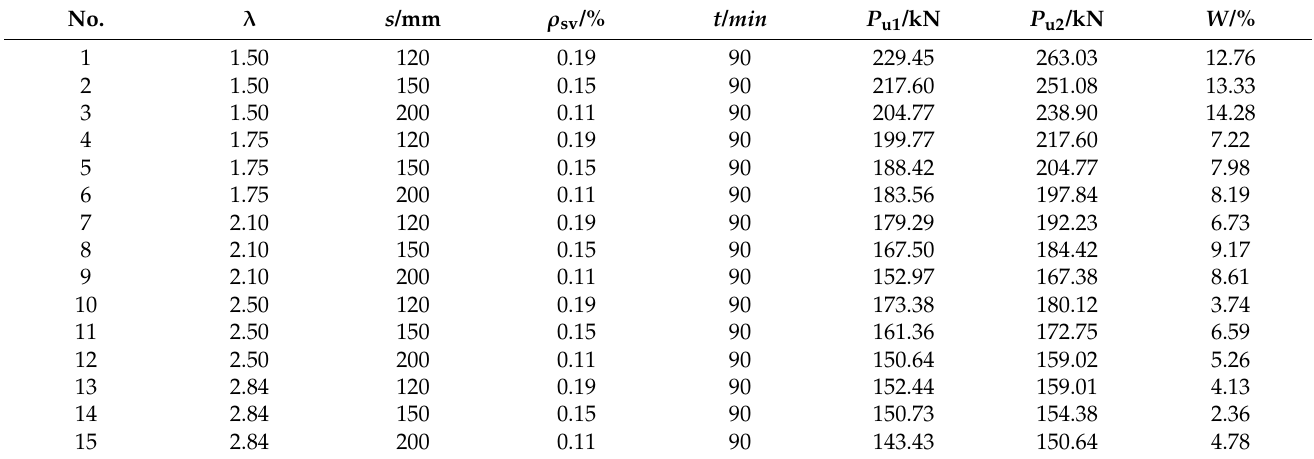
Table 3. Comparison of the failure load between the direct and indirectly loaded beam after fire exposure.